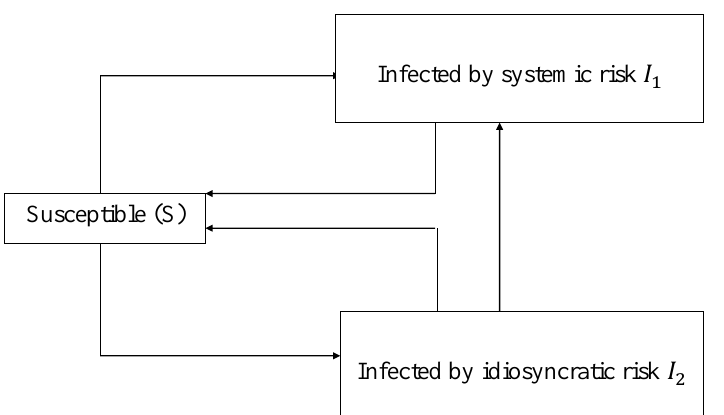
Figure 3. Transfer diagram for the SIIS (Susceptible-Infected1-Infected2-Susceptible) model. Boxes represent compartments, and arrows represent the transition from one compartment to another. Both infected assets may recover to the susceptible